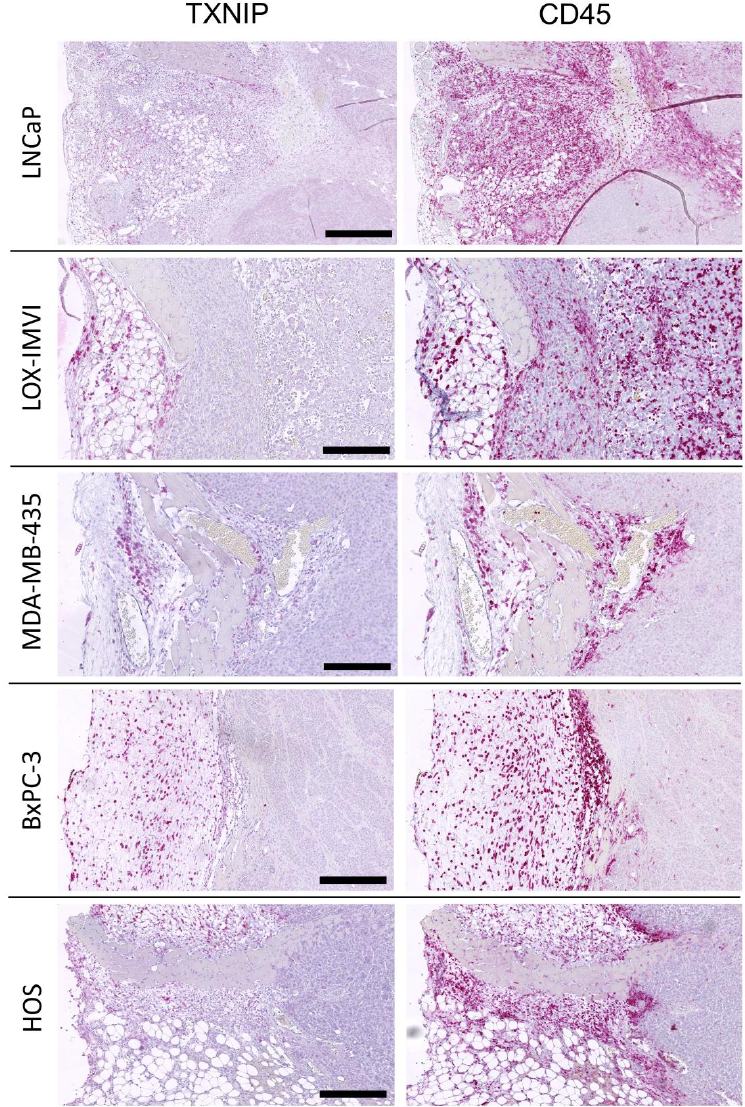
Figure 5. Thioredoxin interacting protein (TXNIP) and CD45 immunostaining results in mouse xenograft tumors derived from di ff erent tumor cell lines. Scale bar: LNCaP = 1000 µ m, LOX-IMVI = 200 µ m, MDA-MB-435 = 200 µ m, BxPC-3 = 500 µ m, HOS = 200 µ